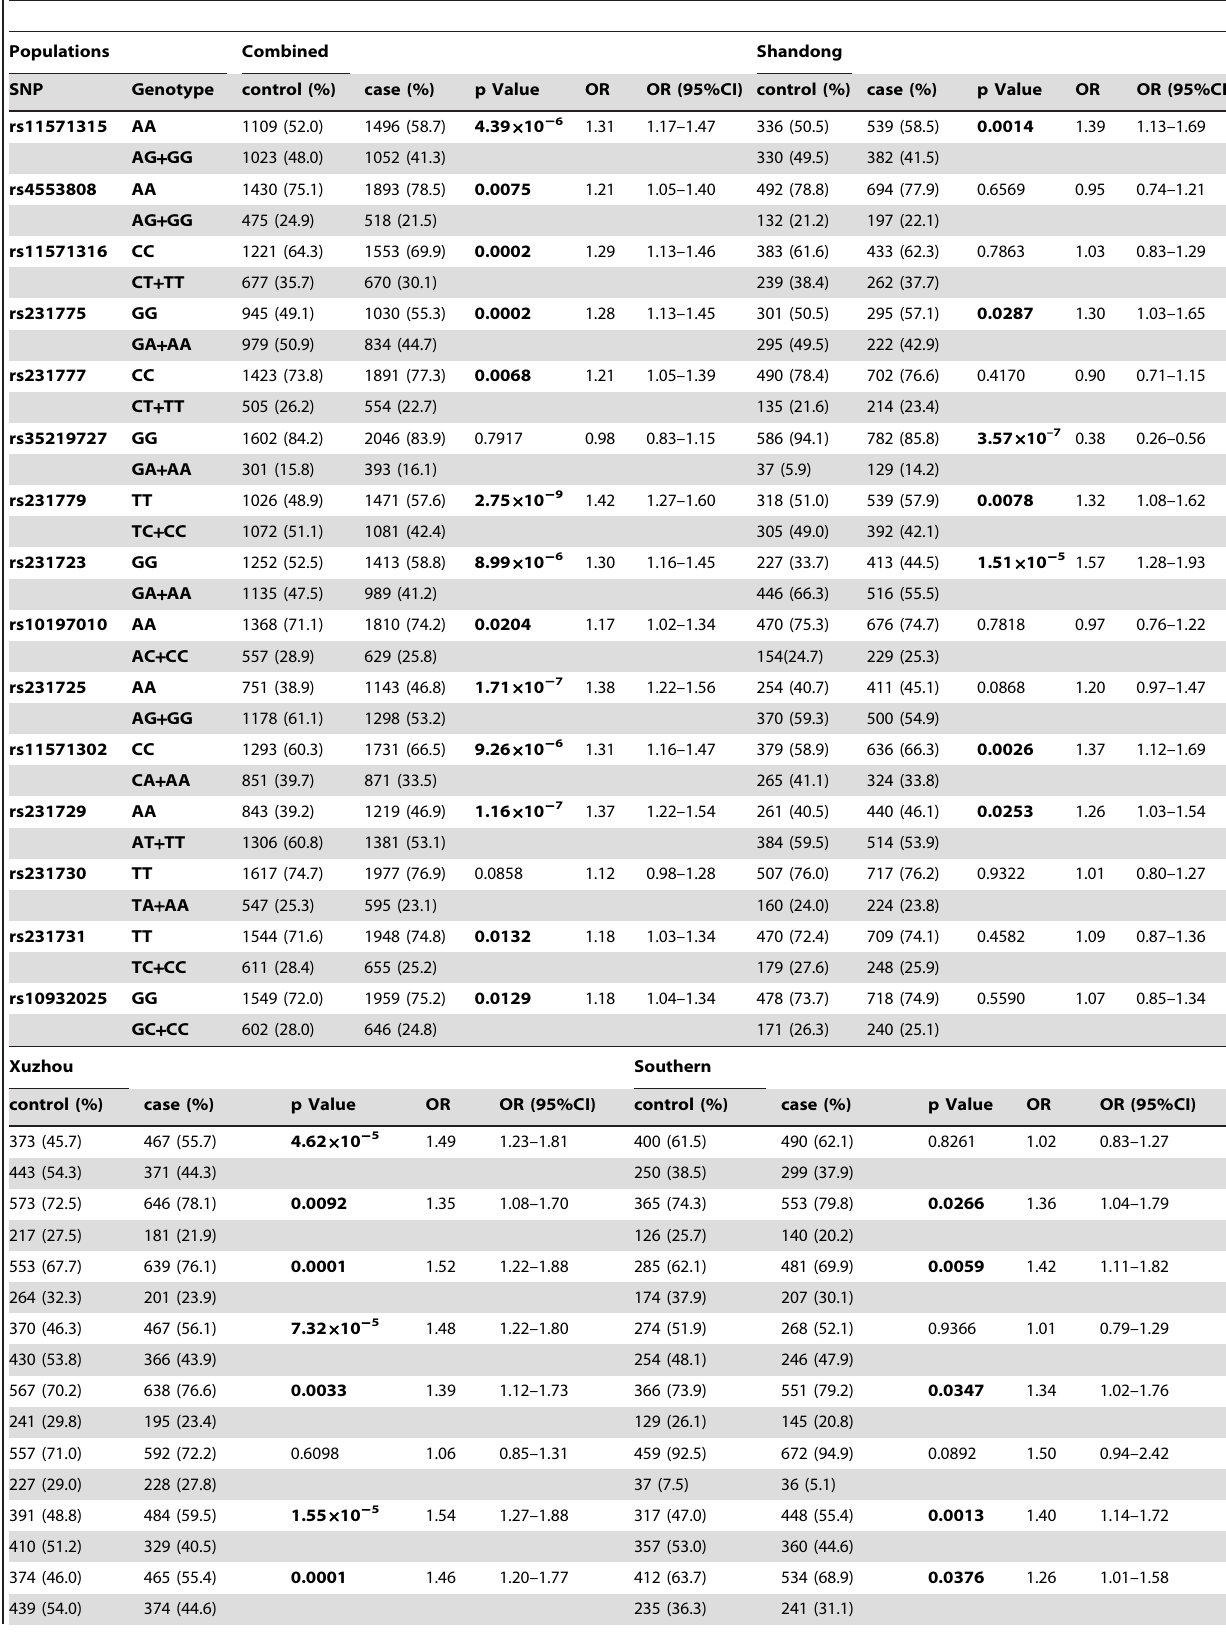
Table 2. Genotype distributions of the SNPs in the CTLA4 gene region in GD patients and controls in different populations.